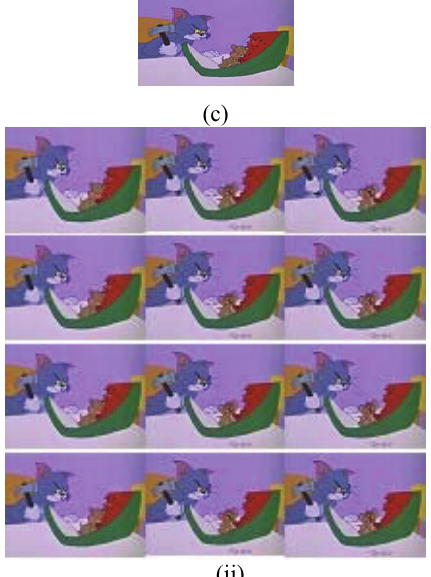
Fig. 6.3 (c) Results of the proposed CBVR system over cartoon database: (i) input query clip and (ii) some of the